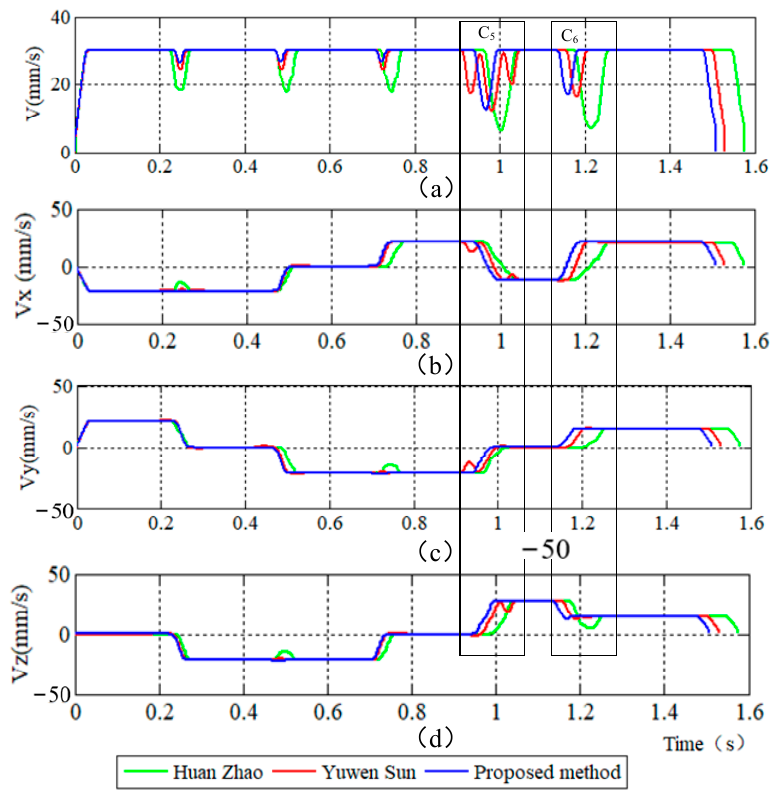
Figure 9. Curvature derivative profiles of 3D tool path.